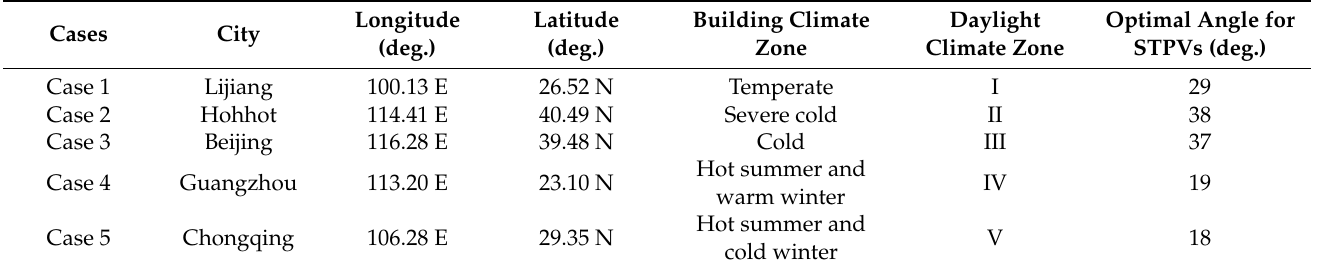
Table 1. Information on the studied